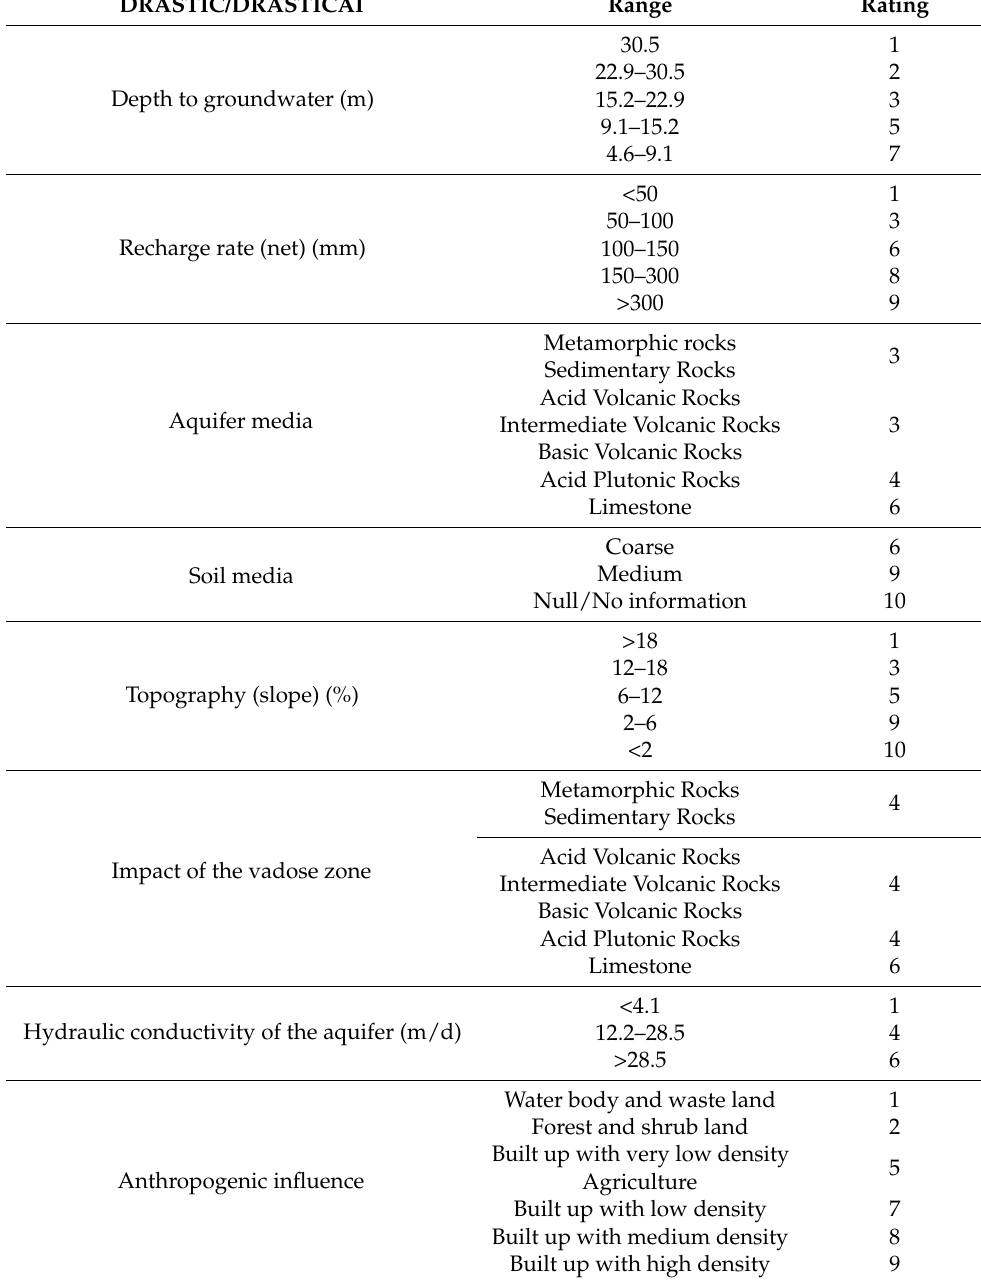
Table 3. DRASTIC (Source: [9]) and DRASTICAI